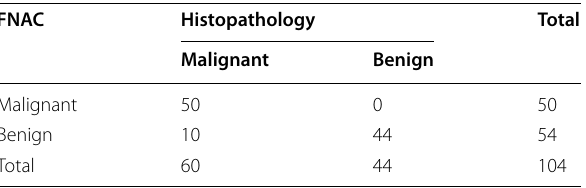
Table 1 Cross‑tabulation between results of FNAC and final histopathology